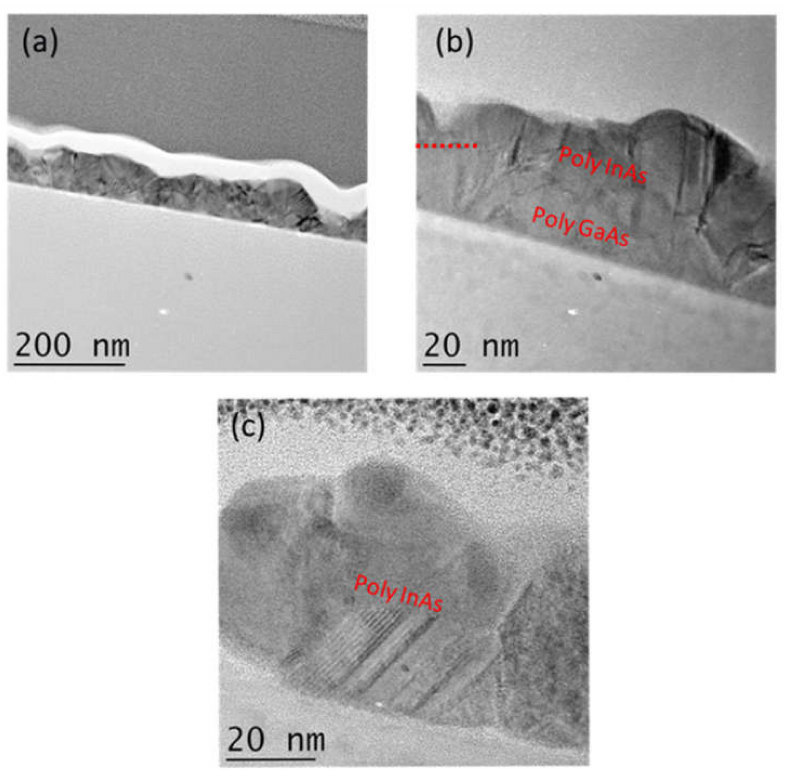
Figure 2. XTEM images of ( a , b ) 25 nm poly GaAs + 25 nm poly InAs (dotted line in ( b ) indicates the position of the interface at the left-hand side of the image) and ( c ) 25 nm poly InAs on glass.